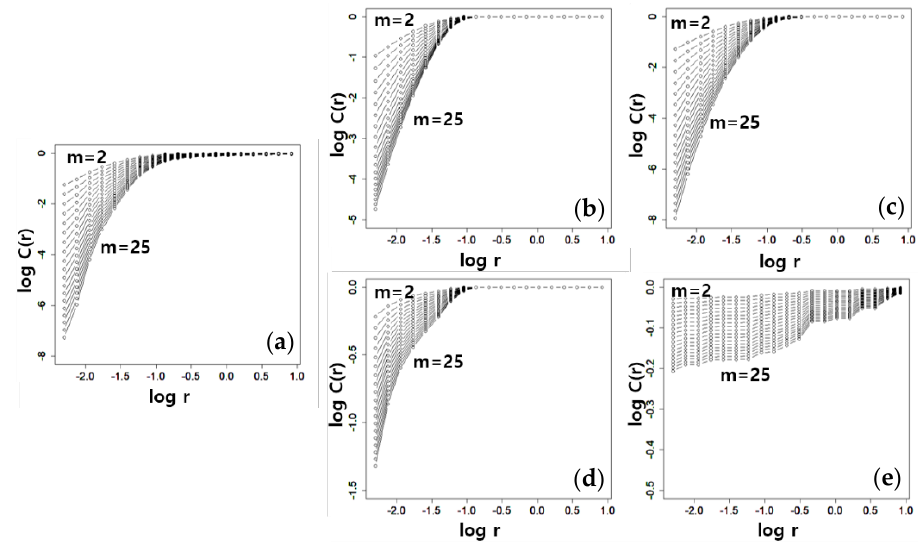
Figure 8. Correlation function versus radius r for ( a ) water level data, ( b ) tide component, ( c ) wave component, ( d ) noise component, and ( e ) rainfall-runoff component.